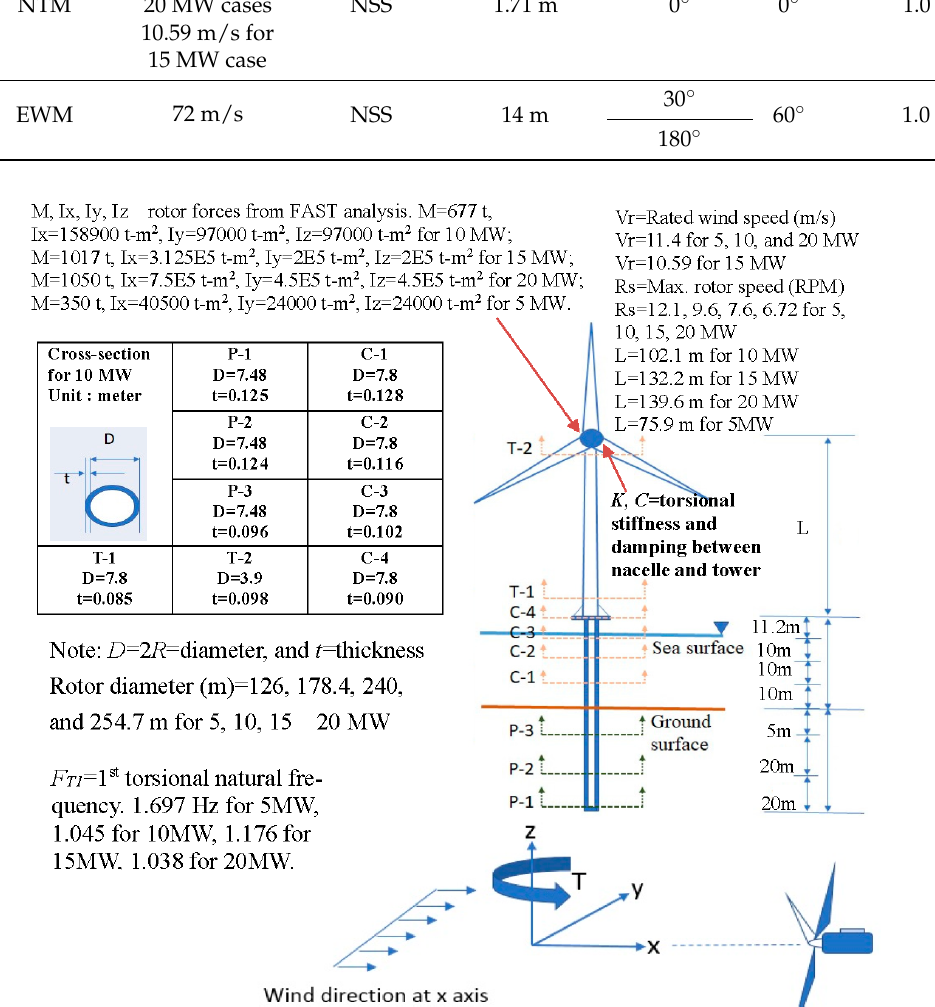
Figure 3. Finite element model and the section dimensions of the final design result. Table 2. The DLCs used in the settlement analysis of the OWT support structure.